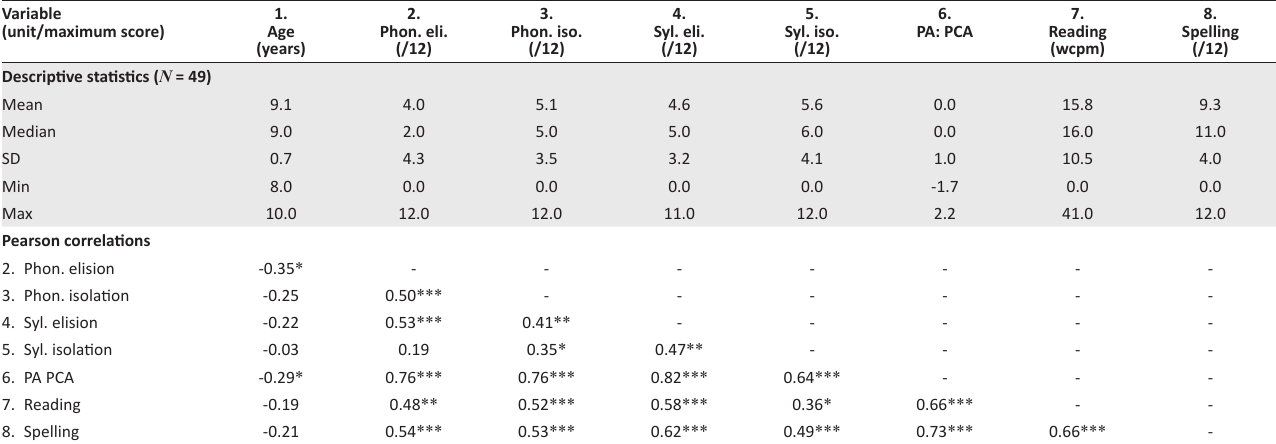
TABLE 1: Study 1: Descriptive statistics and Pearson correlations for phonological awareness, reading, spelling and age. Variable (unit/maximum